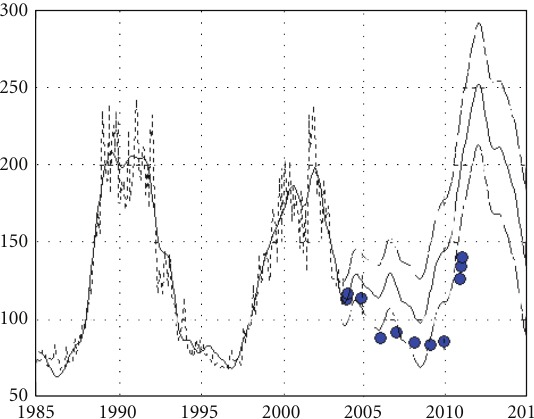
Figure 2: Model, prediction, and epignosis of the monthly mean in- dices of 10.7cm radio flux (S.F.U) pattern. Dotted line demonstrates the real data. Dashes show the one sigma intervals. Blue dots are principal epignosis control marks. Abscissa axis fix years of the last modeled and predicted intervals. Ordinate axis shows S.F.U. values.